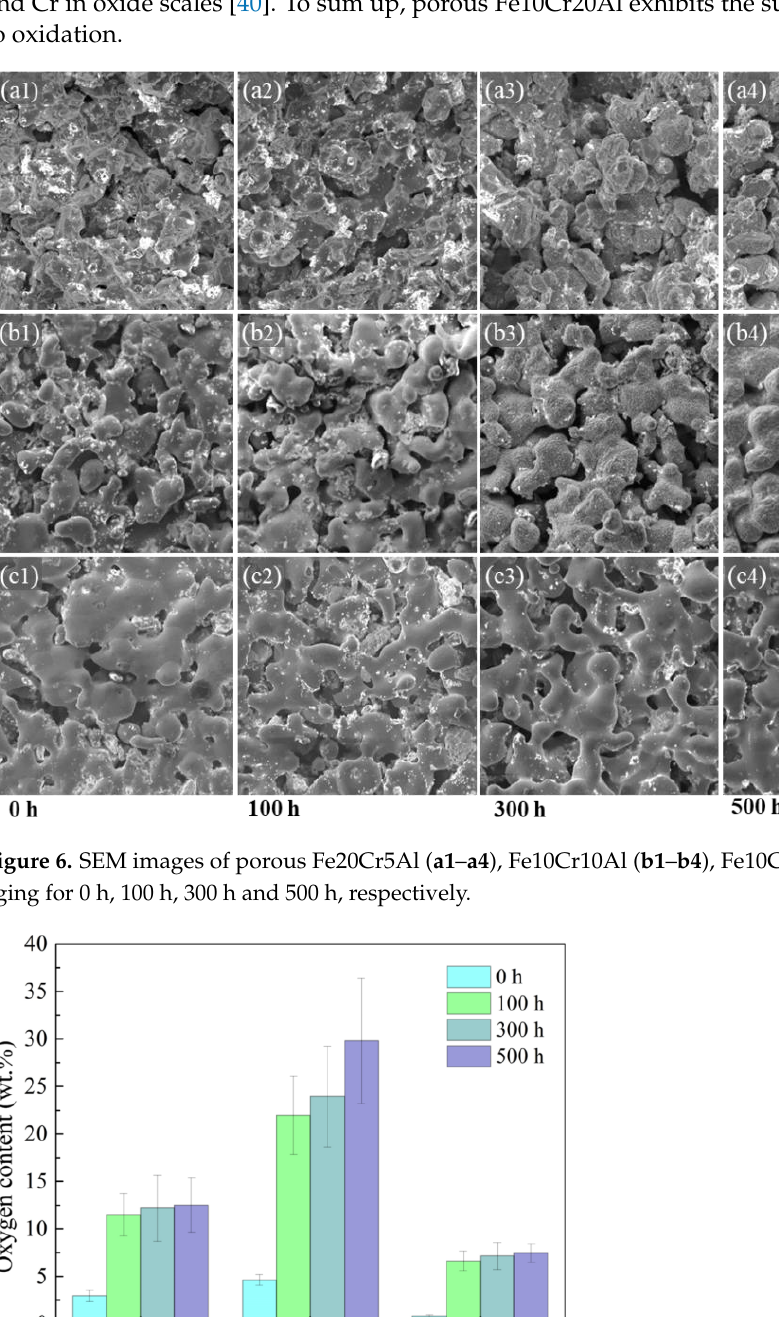
Figure 7. Oxygen content of the aged porous Fe-Cr-Al materials determined by EDS.